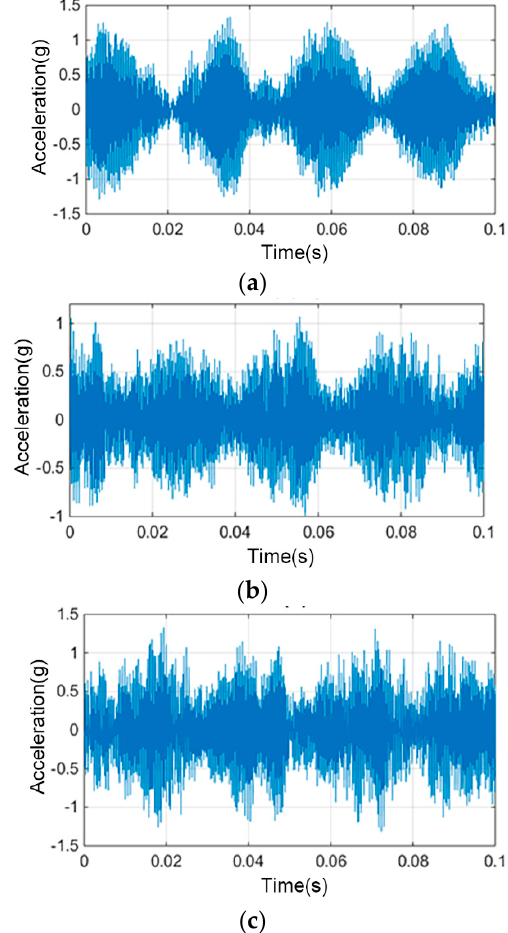
Figure 9. Comparison of time-domain signals after operating for 7.5 h ( a ), 975 h ( b ), 1020 h ( c